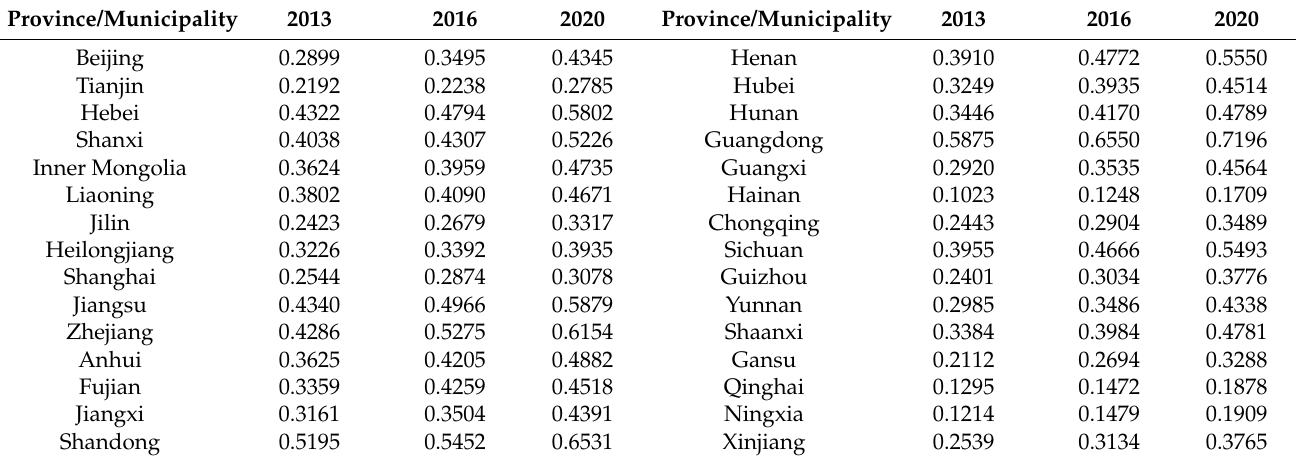
Table 4. The development level of integrated